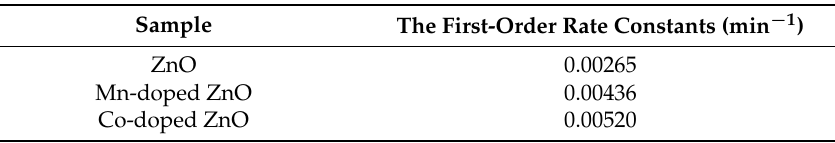
Figure 6. The absorption spectra of MO degraded by ( a ) ZnO; ( b ) Mn-doped ZnO; ( c ) Co-doped ZnO; ( d ) ln( c t / c 0 )- t figure. Cycling performance of ( e ) Mn-doped ZnO; ( f ) Co-doped ZnO. Table 2. The first-order rate constants of all the